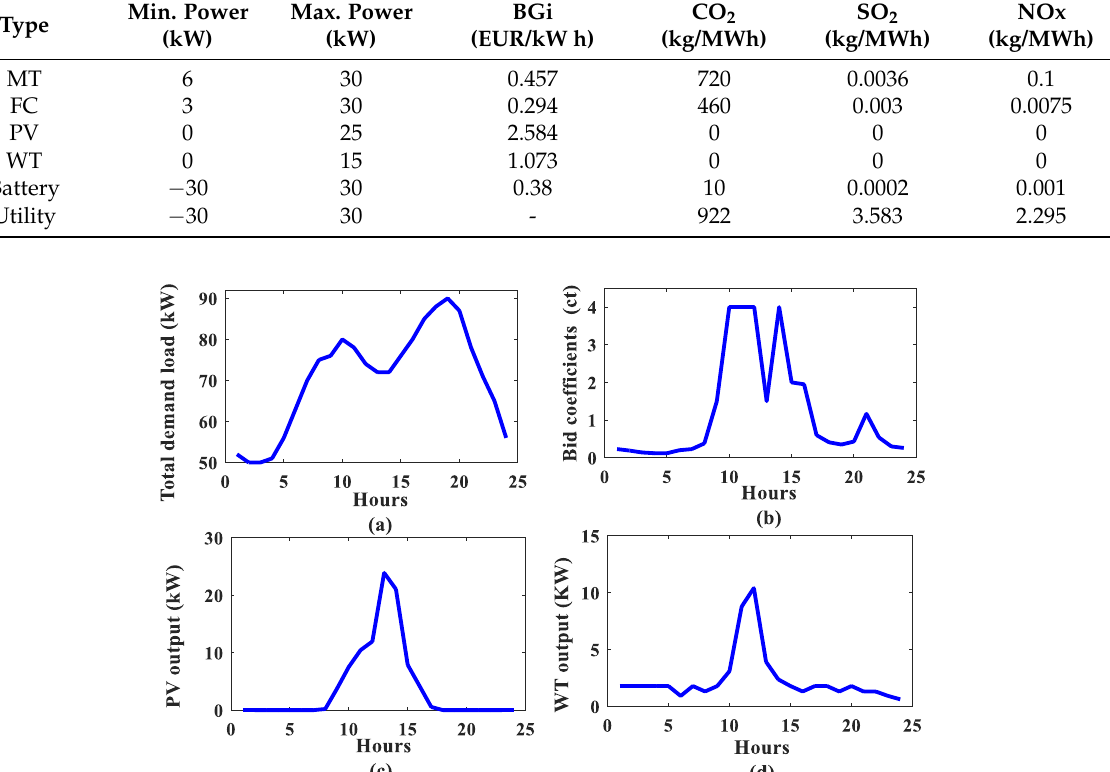
Figure 3. ( a ) Forecasted demand load; ( b ) bid coefficients of MG sources; ( c ) the output power from photovoltaics (PV); ( d ) wind turbines (WT). photovoltaics (PV); ( d ) wind turbines